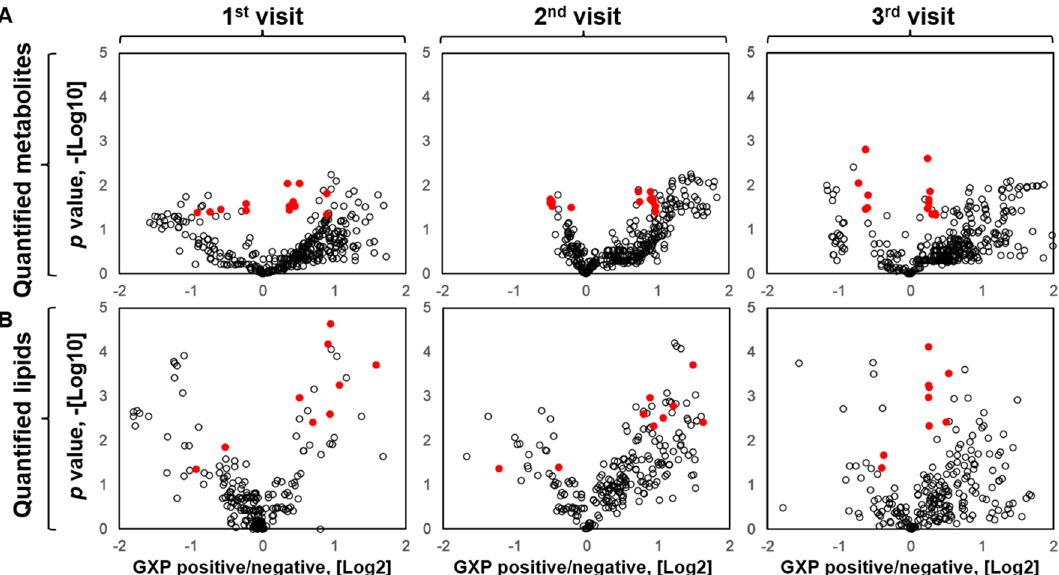
Figure 6. Statistical differences in molecular profiles for GXP-negative and GXP-positive groups at each visit. Volcano plots of GXP-positive/GXP-negative fold change and t -test p values for ( A ) metabolites and ( B ) lipids at each visit. Red dots indicate that the identified molecules were statistically different between the two groups in all three visits. The blue dashed lines indicate p- value of 0.05, which is log-transferred in the y-axis: − Log 10 (0.05) = 1.3.